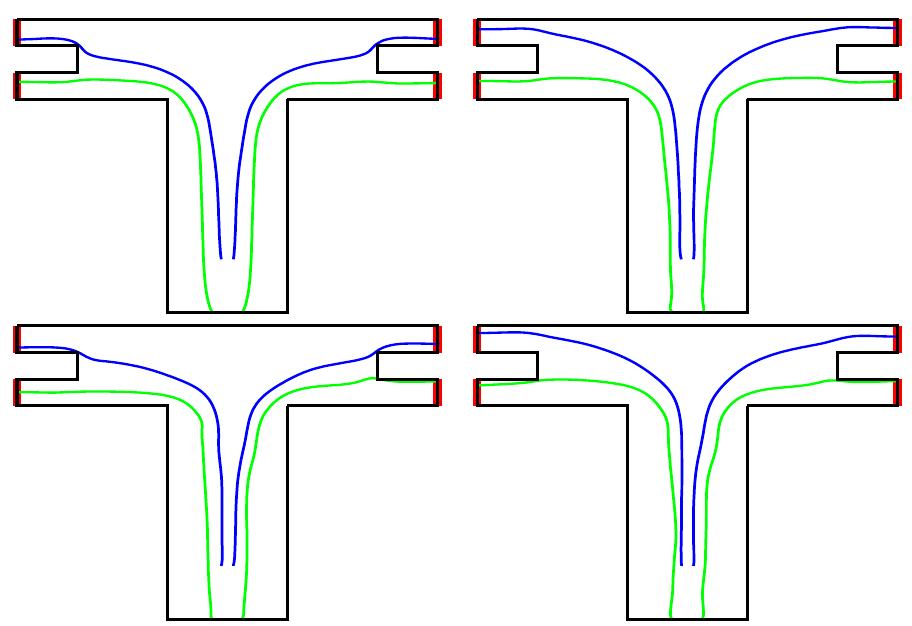
Figure 12. T-shape domain pedestrian trajectories. First row FV in order Bornemann-Rasch algorithm and Dijkstra’s algorithm, second row FV-DG method in the same order. Pedestrian trajectories for starting position x 0 = [ ± 0.4, − 12 ] (blue color) and x 0 = [ ± 1, − 16 ] , respectively (green color). The pedestrians starting at x 0 = [ ± 0.4, − 12 ] cross the line [ .,0 ] at time t = 9 s and reach the more distant exit at time t = 18 s. The pedestrians starting at x 0 = [ ± 1, − 16 ] cross the line [ .,0 ] at time t = 15 s and reach the nearer exit at time t = 23